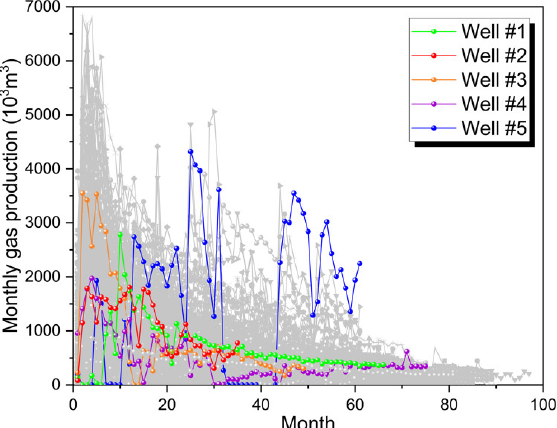
Figure 1. Monthly production of some wells in Duvernay Formation.